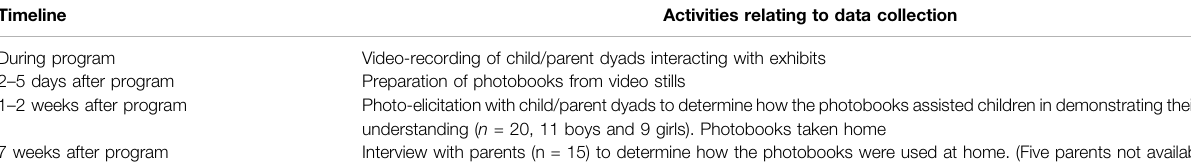
TABLE 1 | Summary of data collection.